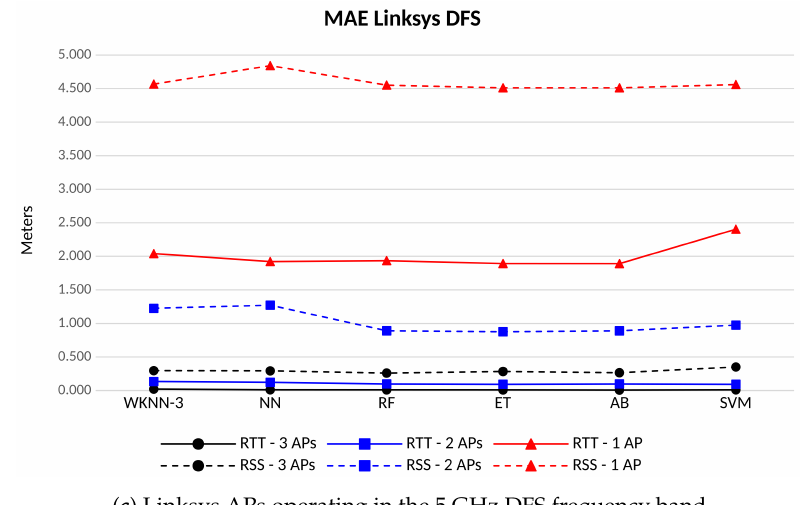
Figure 12. MAE for different ML algorithms and number of APs of the same vendor and channel. FTM-based in solid lines, RSS-based in dashed lines.